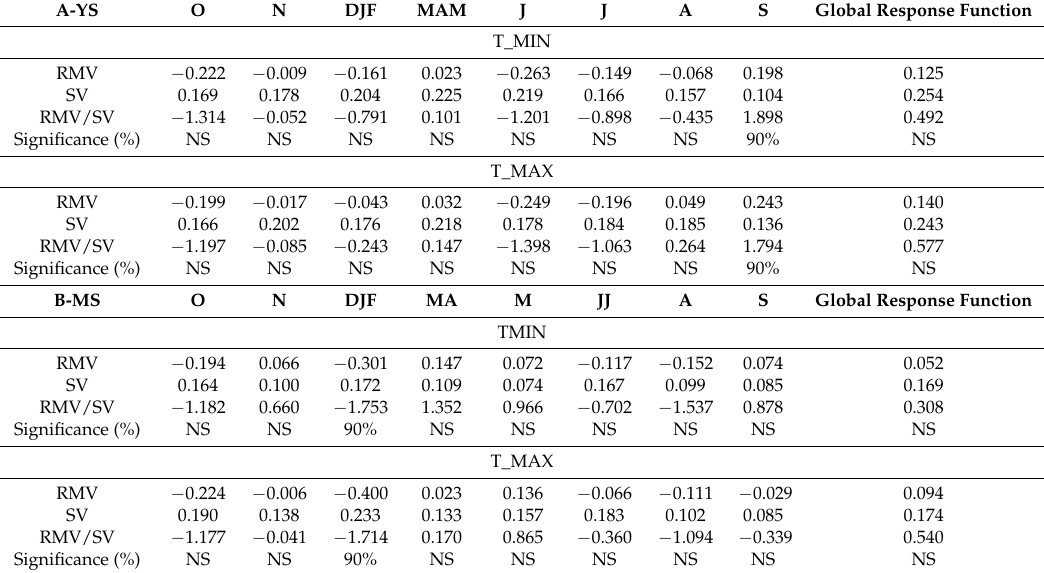
Table 2. Response function analysis of the residual tree ring chronology of Quercus suber to monthly minimum TMIN and maximum TMAX temperature from October ( t − 1) to September ( t ): A- for the period 1974–2008 in the young stand (YS) and B- for the period 1937–2008 in the mature stand (MS).